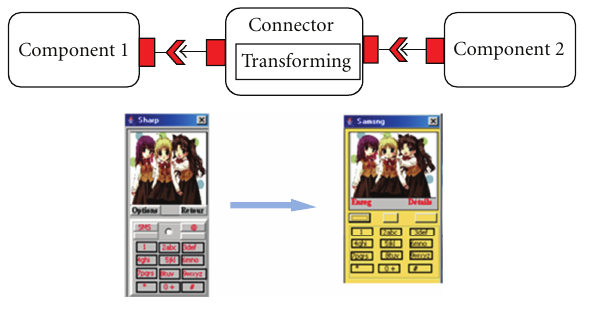
Figure 24: Adaptation Platform.